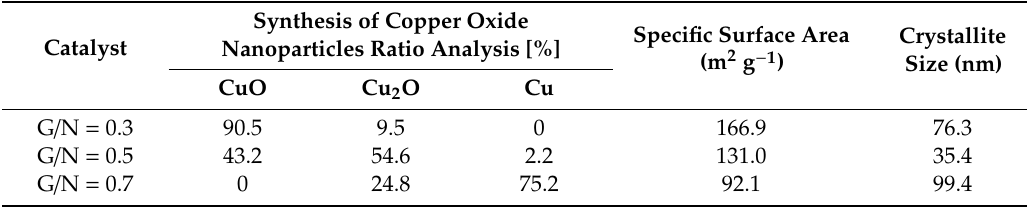
Table 1. Specific surface area, crystallite size, and determination of copper oxide nanoparticles synthesized at di ff erent glycine / nitrogen (G / N)